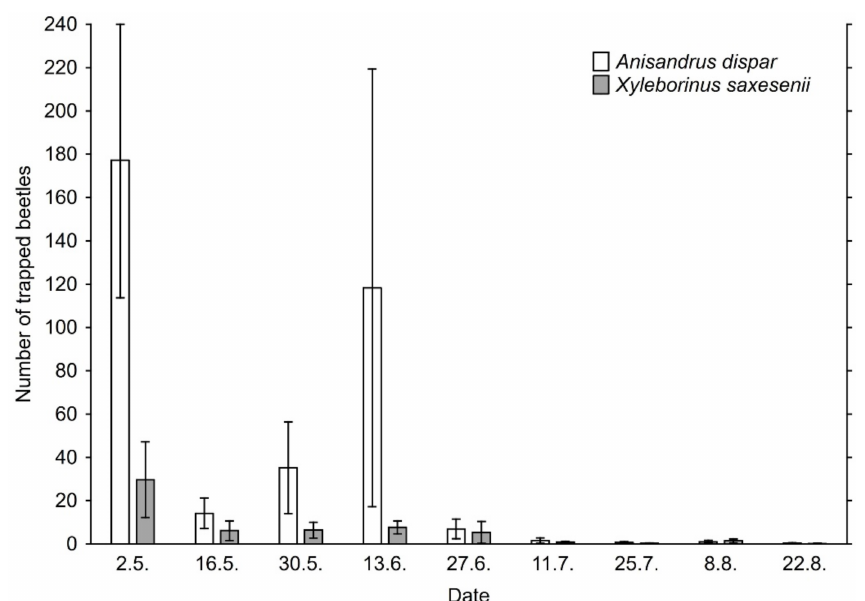
Figure A1. Number (mean ± SE) of individuals of the two most abundant ambrosia beetle species captured per sample in particular sampling periods from April to August 2020. Each sample represented the beetles captured in one trap during 2-week